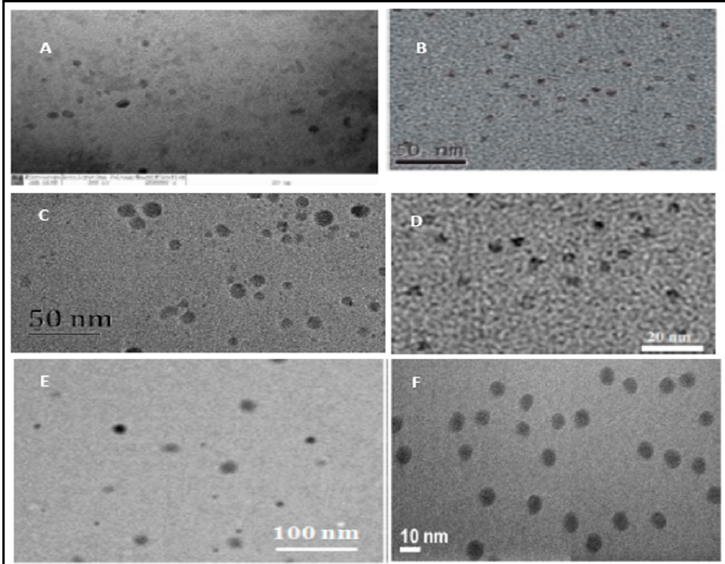
Figure 3. TEM micrograph of ( A ) GQDs from graphite (Adapted from [79]) ( B ) CQDs from glucose (Adapted from [80]) ( C ) GQDs from CA (Adapted from [81]) ( D ) CQDs from glucose (adapted from [82]) ( E ) NCQDs from DEA (adapted from [83]) ( F ) NGQDs from CA and Urea (adapted from [84]).